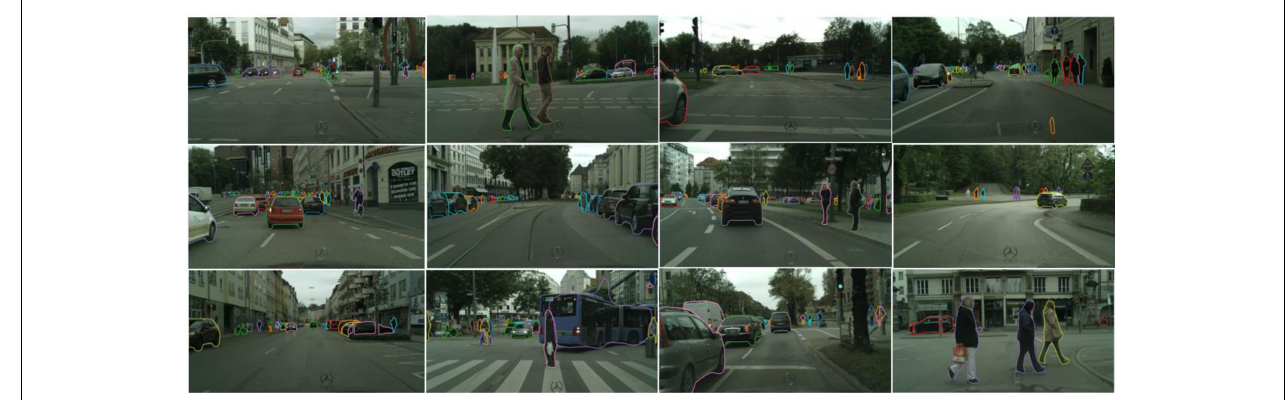
FIGURE 12 | Result images of the Cityscapes data set.